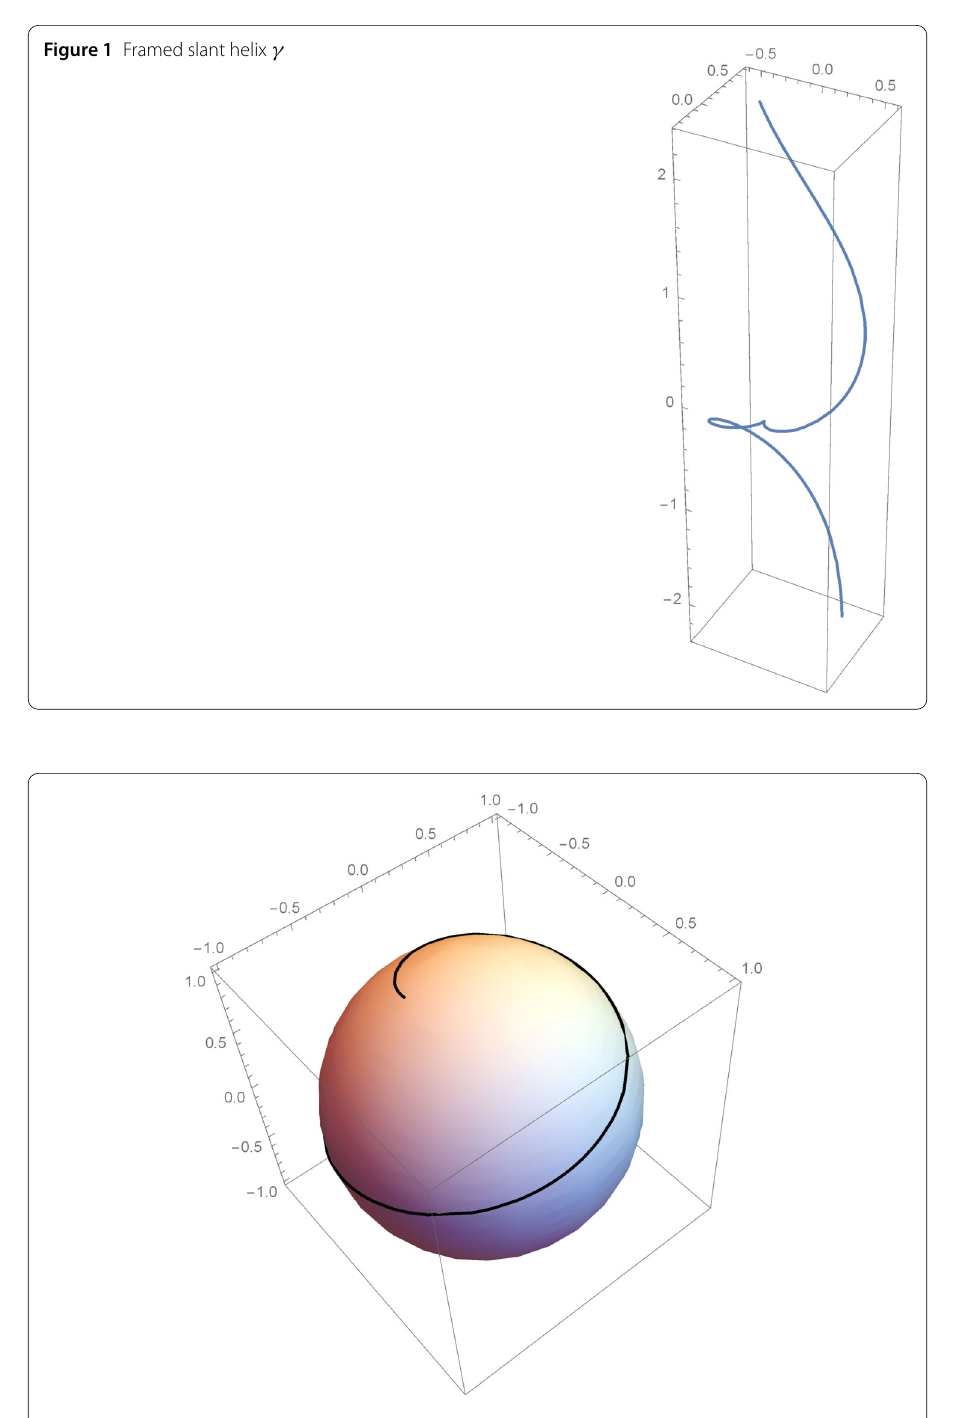
Figure 2 v -indicatrix of